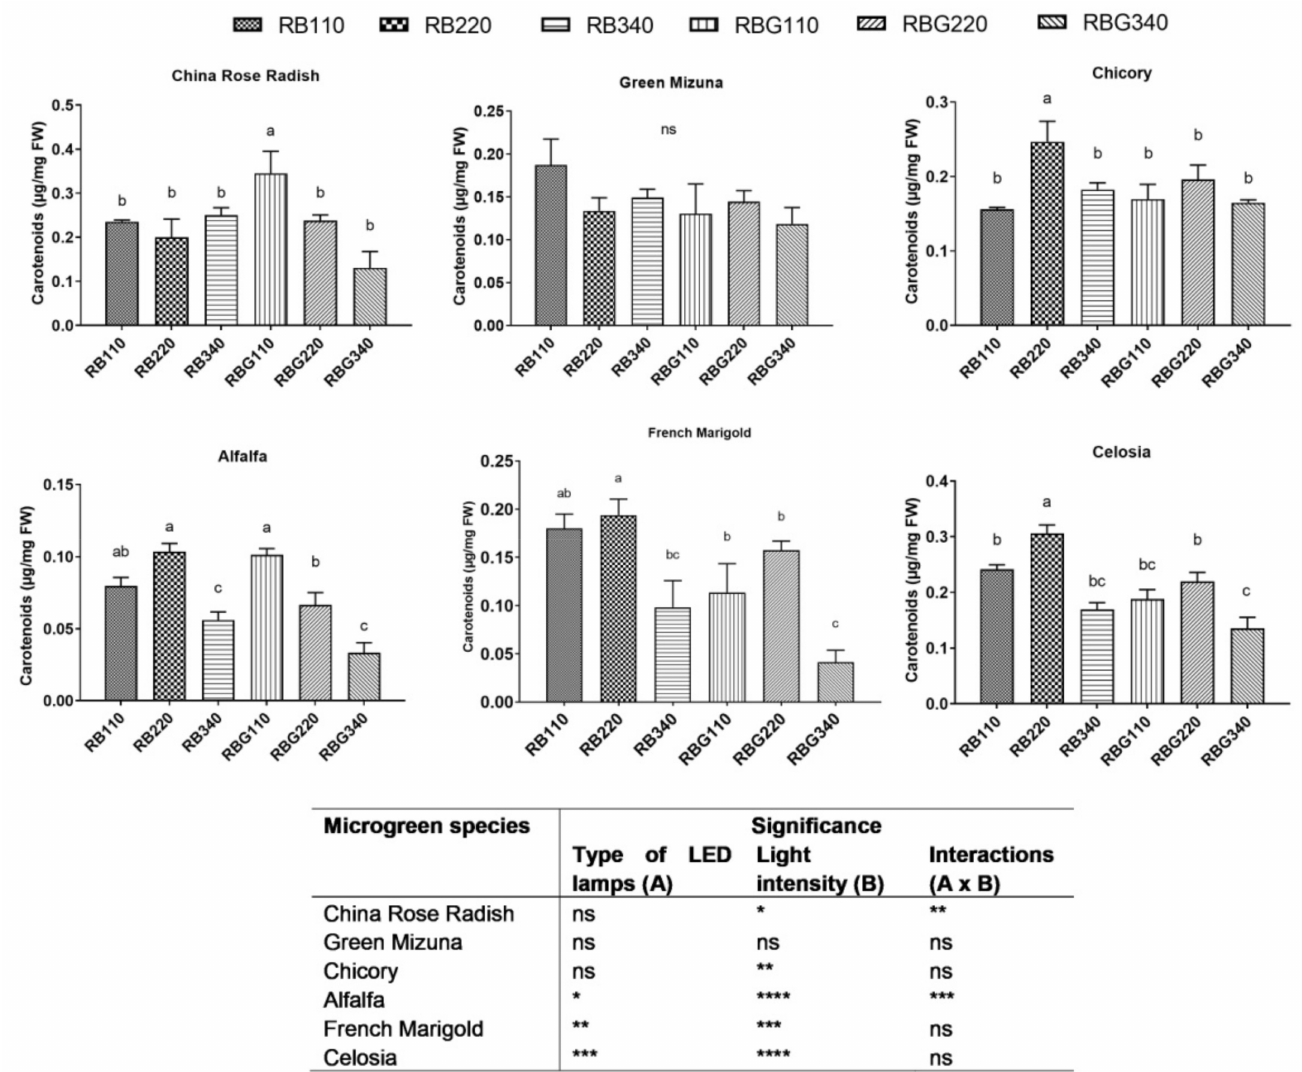
Figure 5. Total carotenoids content from the six microgreen species affected by different light environments. Data are shown as means with at least five independent biological replicates and error bars indicate standard error (SE). Data were subjected to two-way analysis of variance and differences were analyzed by Tukey’s post-hoc. Different letters denote significant differences at p < 0.05. Levels of significance of the parameters assessed for each microgreen species considered where: ns, *, **, ***, ****, are not significant, significance at p < 0.05, 0.01, 0.001, and 0.0001 respectively. When there was not significant A × B interaction, the effect of light spectra (A) and light intensity (B) was evaluated separately using one-way ANOVA and t -test, respectively (Supplementary Table S1). Different letters on the histograms within each light spectrum (RB and RGB) indicate significant differences among light intensity (Tukey’s test, p <